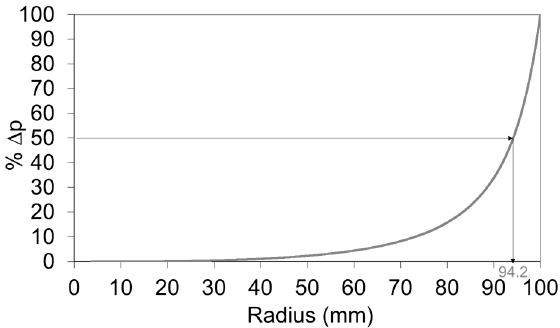
Figure 3. Pressure increase versus the flame front radius in a combustion of iso-octane, with a stoichiometric fuel/air equivalence ratio, 0.1 MPa and 353 K initial conditions.